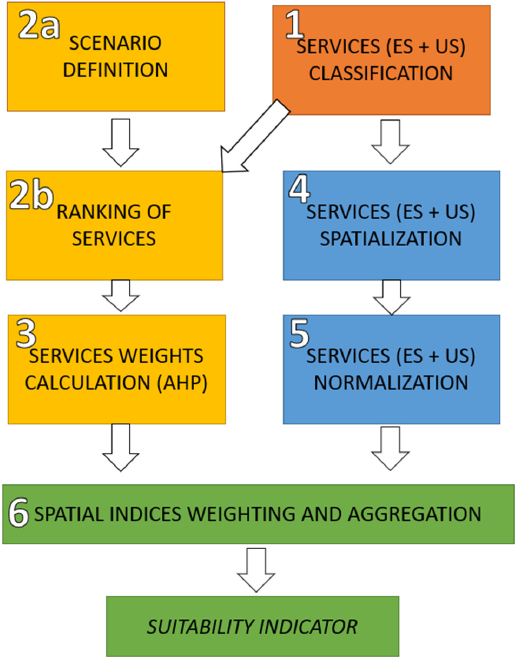
Figure 2. Methodological steps of